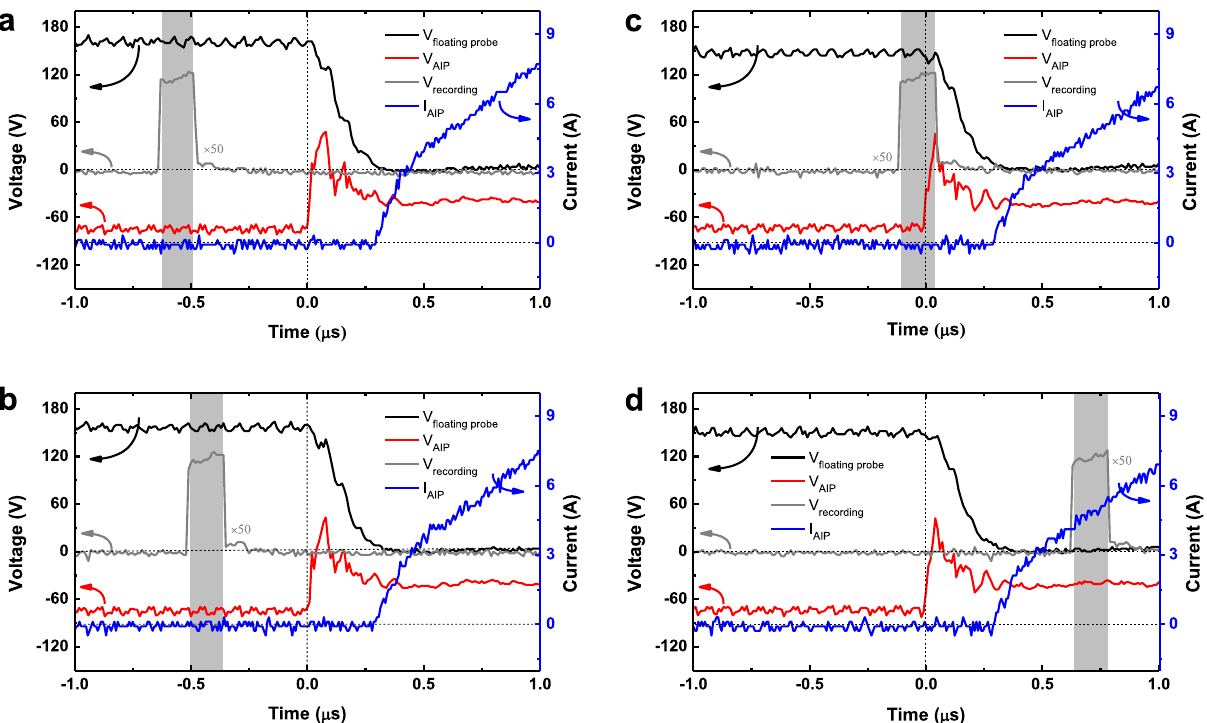
Figure 6. Floating probe voltage ( V float ), voltage and current of the AIP ( V AIP and I AIP ), and recording voltage signal of the ultra-high-speed camera ( V recording ) at a V AIP of − 75 V, P RF of 34 W, the pressure of 147.3 mTorr, and argon injection of 20.0 sccm. The recording times, t avg , are ( a ) −0.56 µ s, ( b ) −0.44 µ s, ( c ) −0.04 µ s, and ( d ) 0.71 µ s. Each images of Fig. 6(a)–(d) recorded at the same time of Fig. 5(a)–(e), minimum vapor pressure equaling the background argon pressure, σ ex,Al 30 is 10 − 15 cm 2 and ¯ v is 10 8 cm/s for an